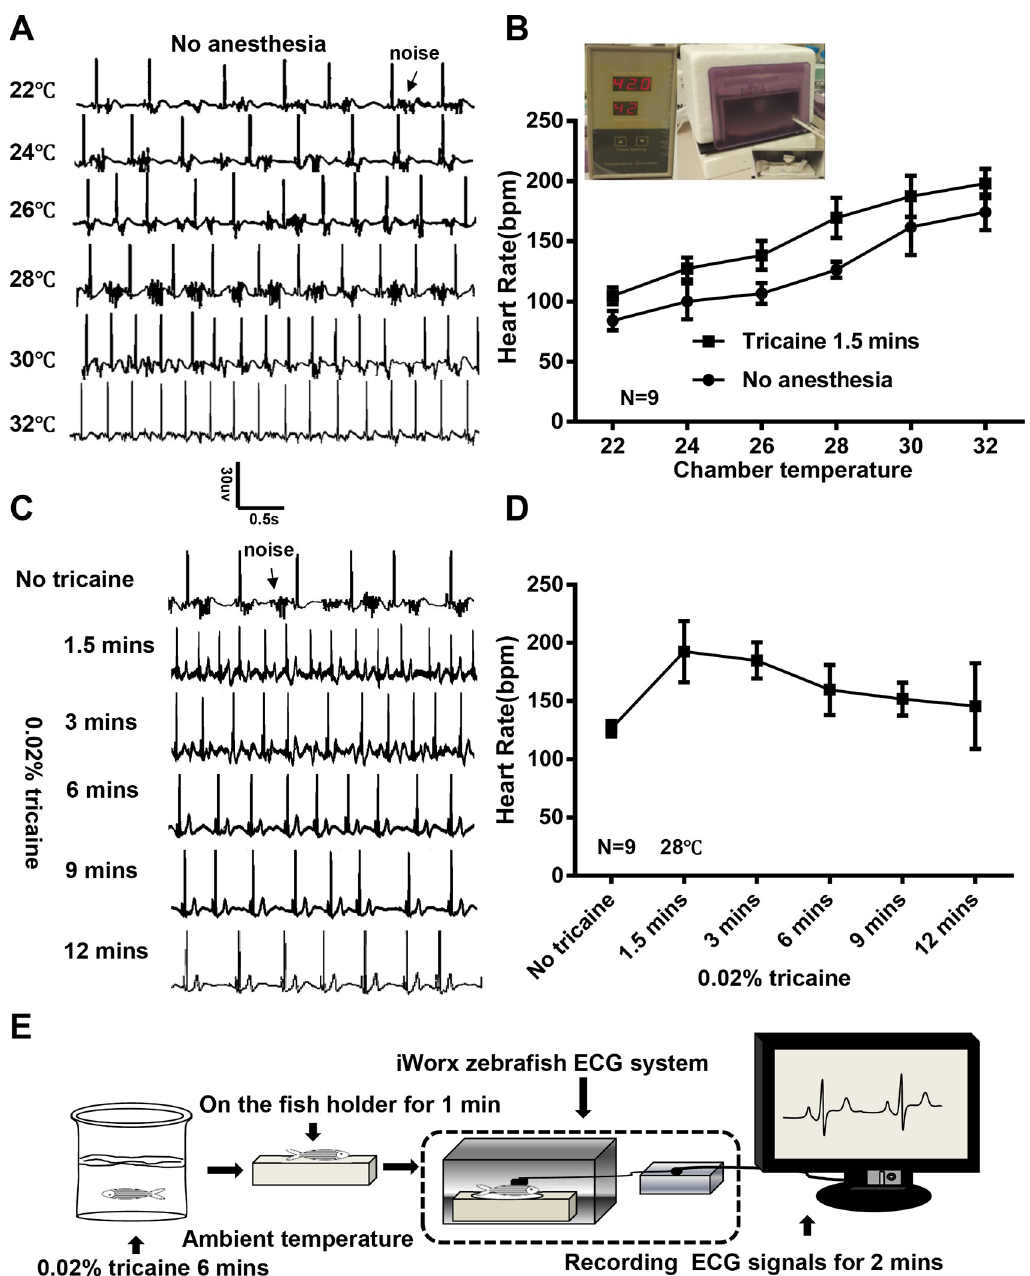
Fig 2. Optimization of temperature and anesthesia for reliable ECG recording in adult zebrafish. A, Representative electrocardiogram (ECG) for a single fish without anesthesia. Chamber temperature was changed from 22˚C to 32˚C. B, Heart rate significantly increased with increased chamber temperature, which is independent of anesthesia. Inset shows in-house temperature-controlled chamber. C, Representative ECG for a single fish before and after anesthethia. Temperature was controlled at 28˚C. Noise caused by gill movement is reduced after 6 minutes of anesthesia. D, Heart rate to the time after anesthesia. E, Schematic of protocol for conducting ECG with the iWorx system. bpm indicates beats per